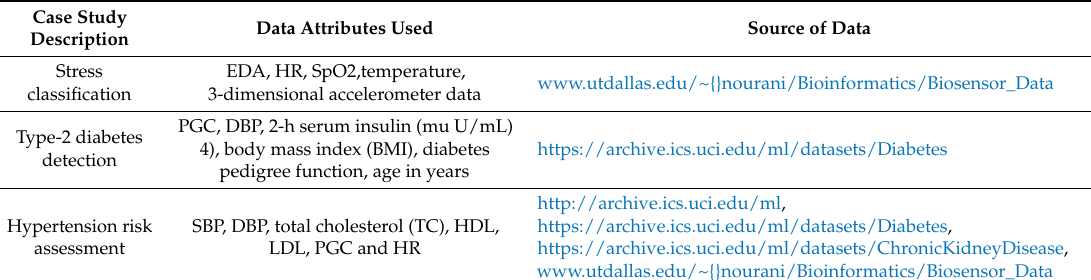
Figure 12. The fog-based system architecture used to deploy the Deep-fog system. Table 3. Datasets used, their attributes, and the source of data.